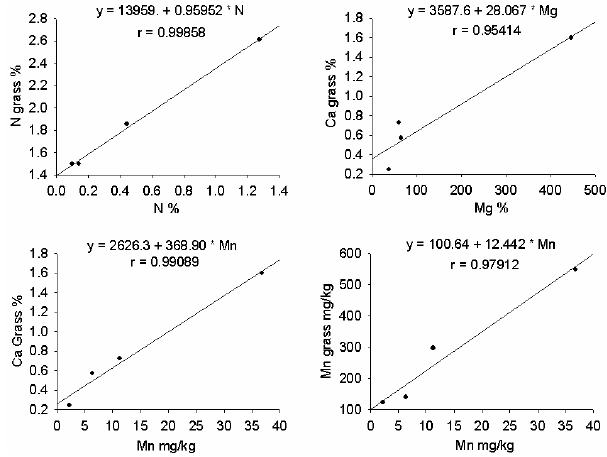
Figure 7. Correlation between soil macro- and micronutrients avail- able and total plant amounts in D. antarctica